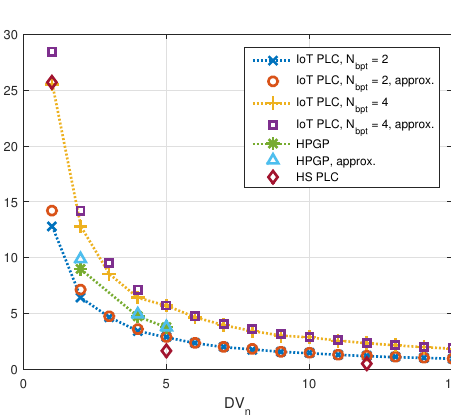
Figure 9. Transmission rate of IoT PLC according to diversity numbers.